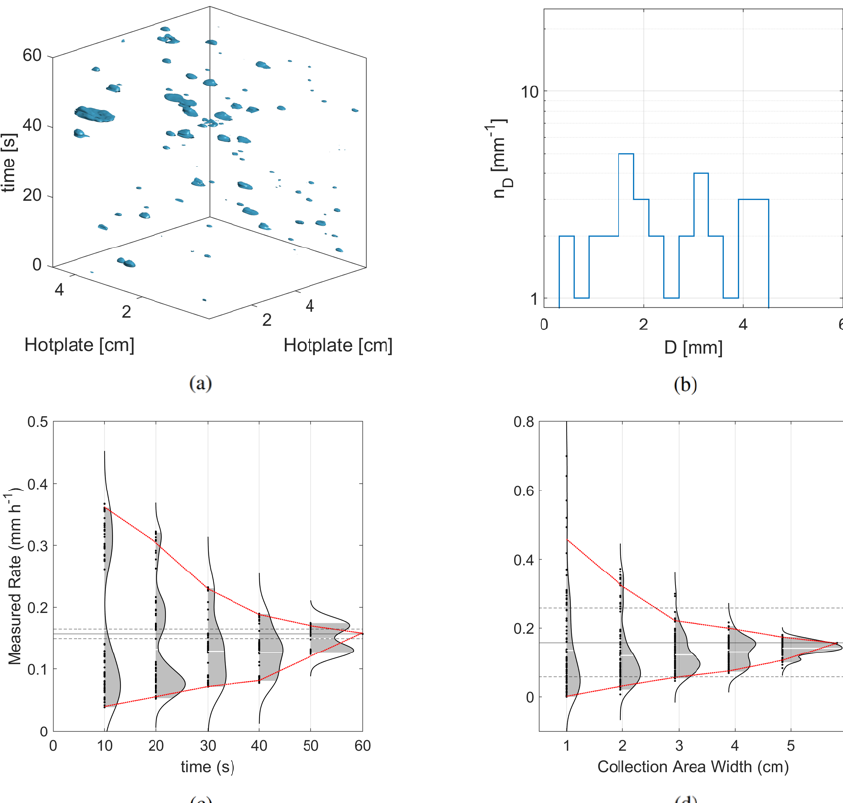
Figure 6. Recalculation of R calc from 1000 iterations of a 1min DEID dataset from 8 March 2020 at 15:14MST with rain rate R DEID = 0.1mmh − 1 (a) . R calc was calculated using uniformly distributed random segments of time (c) and hotplate sampling area width (d) . As t → 60 and W → W DEID , R calc approaches R DEID